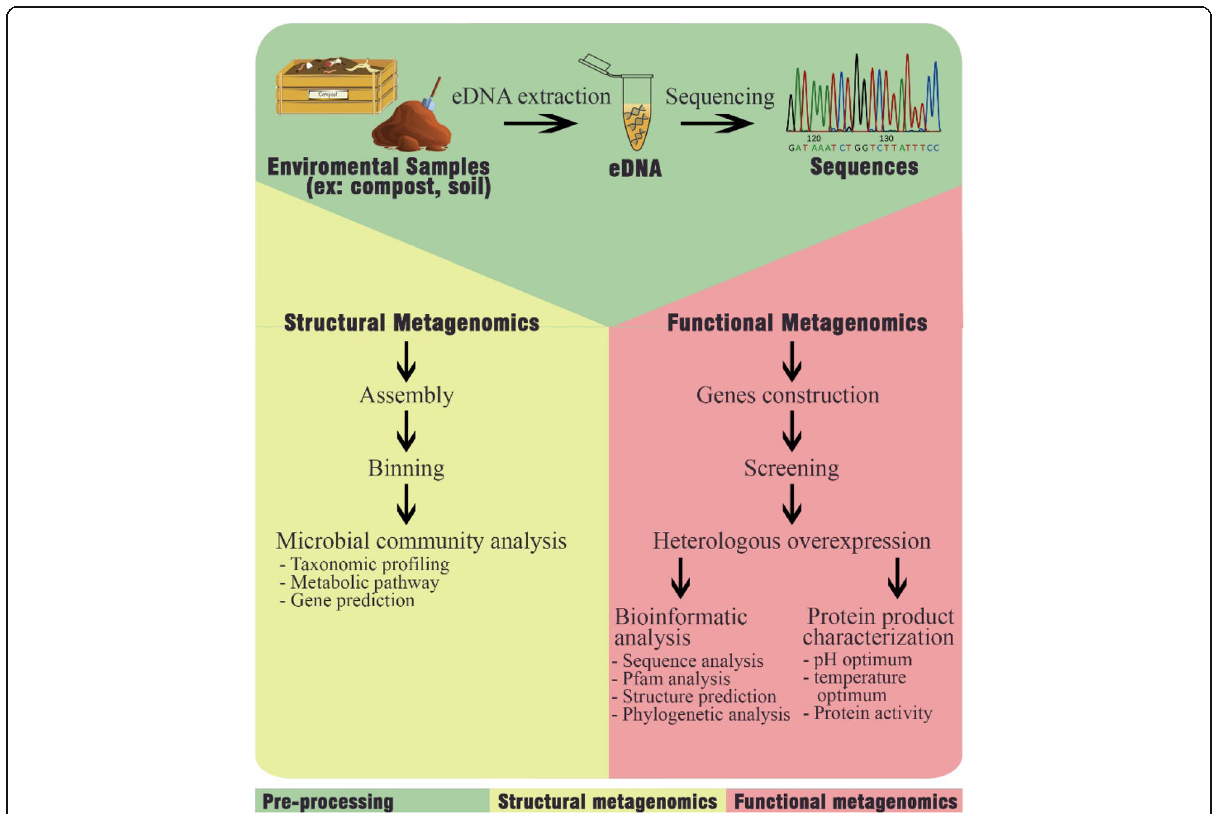
Fig. 1 Framework for metagenomics with two primary studies, structural and functional